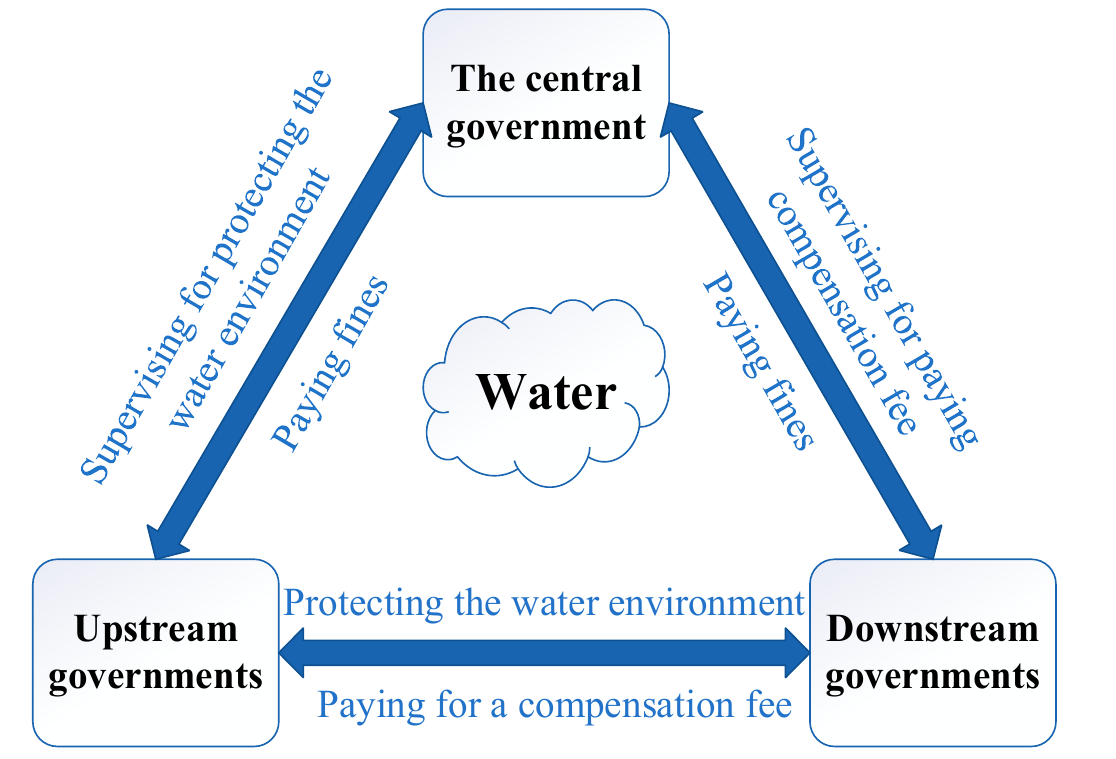
Figure 2. Relationships among upstream, downstream, and central governments in watershed ecological compensation.